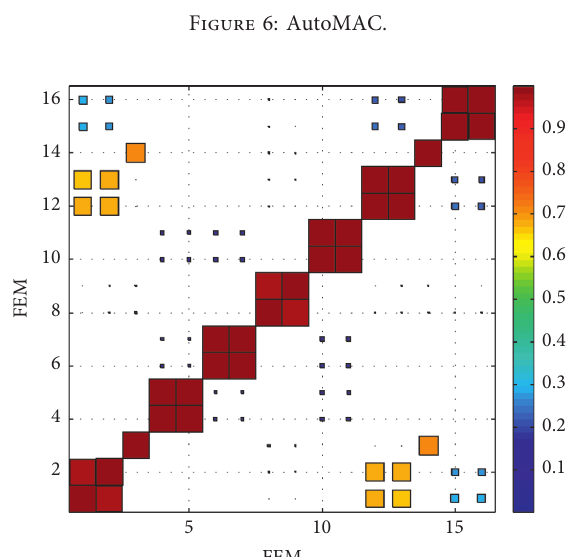
Figure 6: AutoMAC.